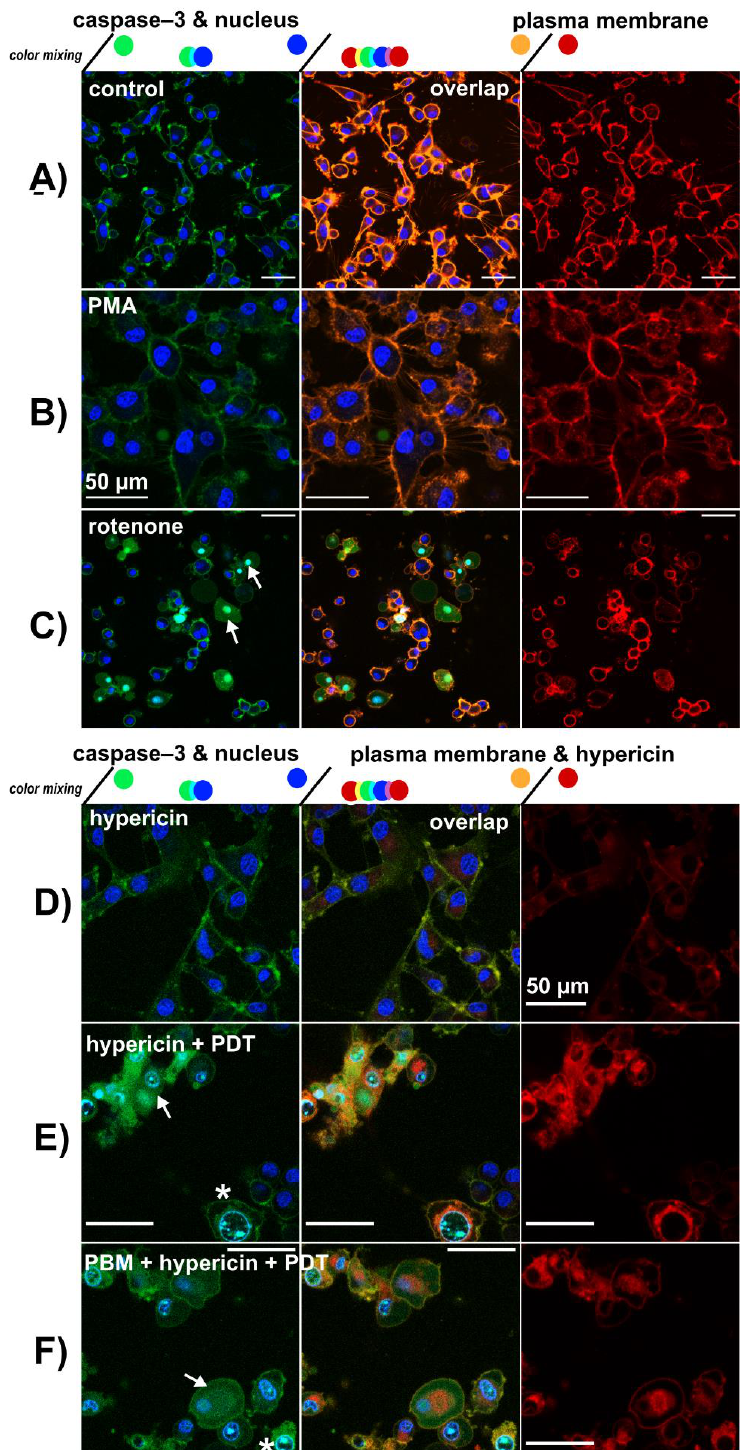
Figure 7. Confocal fluorescence images of NucView ® 488 caspase-3 substrate (green), Hoechst — nucleus (blue), hypericin (red) and Cell Mask Orange — plasma membrane (orange and red) in ( A ) U87 MG cells without treatment, ( B ) treated with 1 µM PMA and ( C ) 10 µM rotenone for 5 h. ( D ) U87 MG cells treated with 500 nM hypericin for 3 h, ( E ) hypericin-PDT and ( F ) PBM-hypericin-PDT detected 5 h after PDT. Scale bar—50 µ m. White asterisks indicate cells with typical apoptotic features stained with Hoechst. White arrows indicate localization of NucView ® 488 caspase-3 substrate in the cytoplasm and